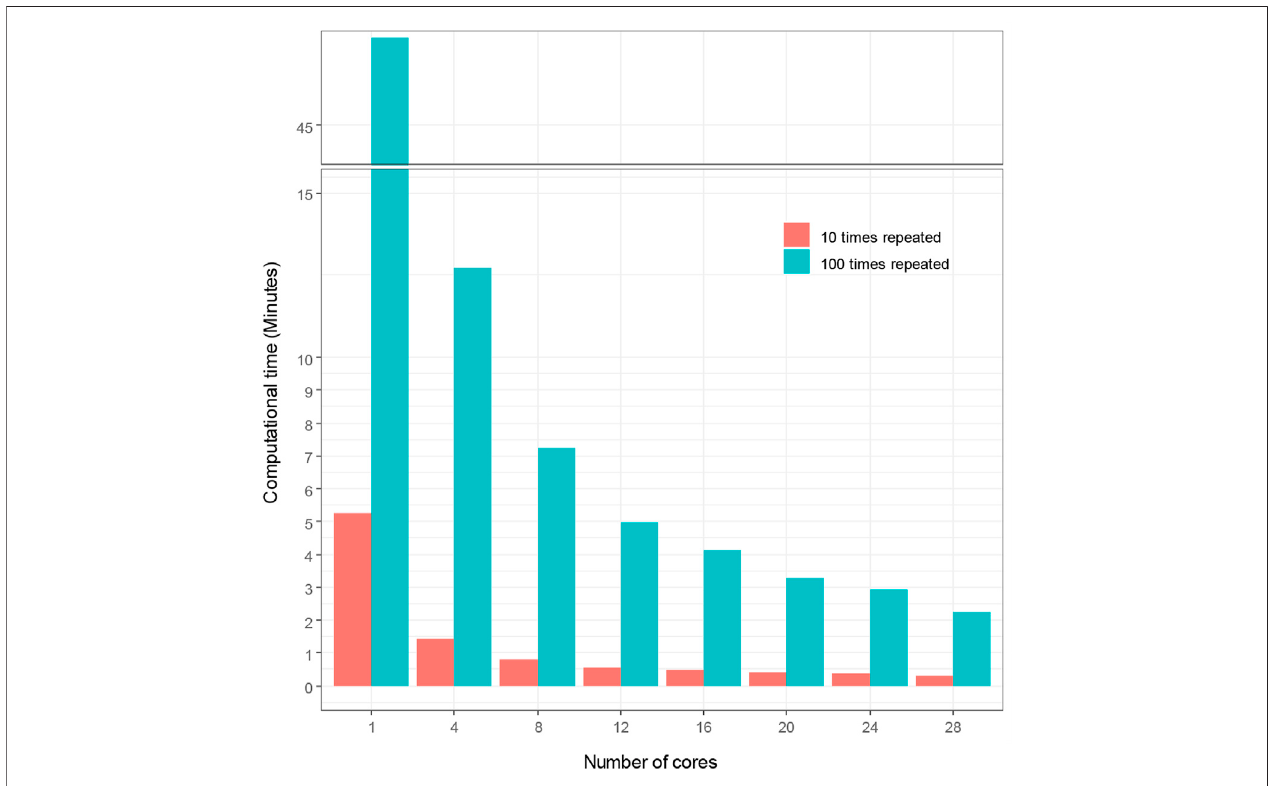
FIGURE 7 | Computational time vs. number of cores with RF